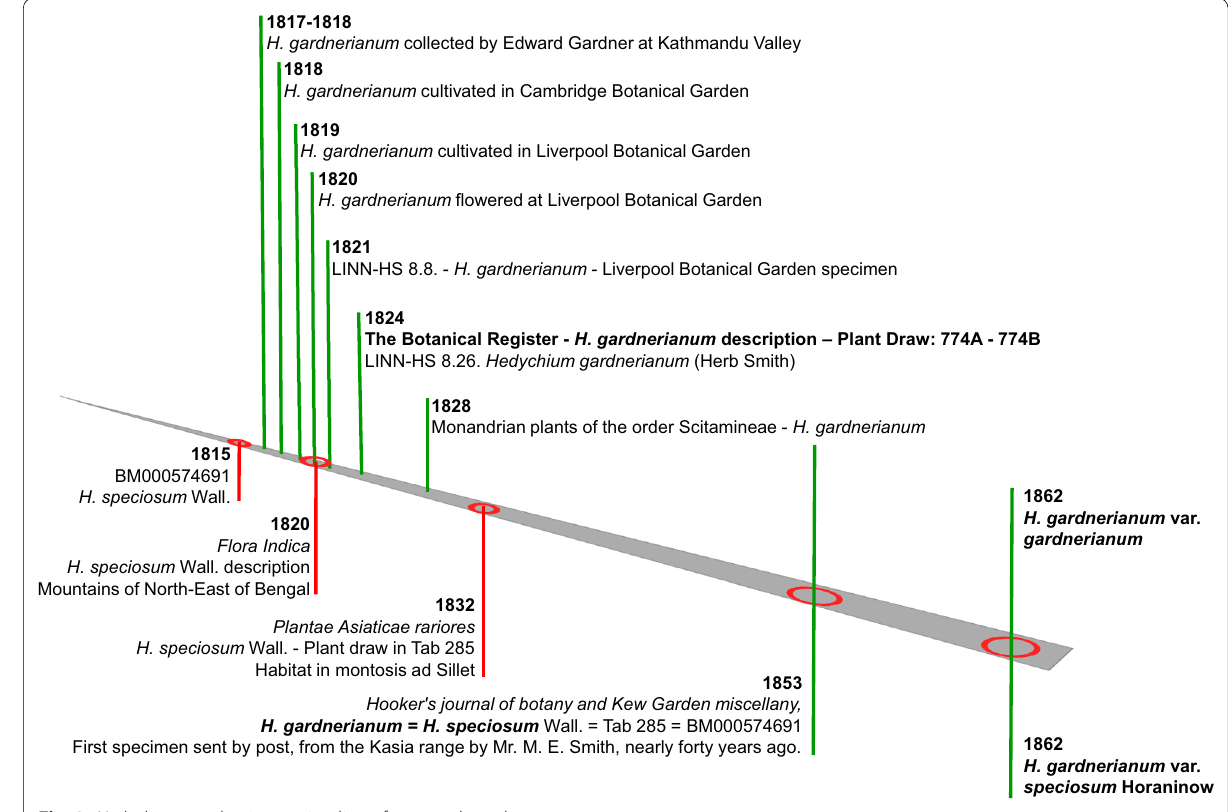
Fig. 3 Hedychium gardnerianum timeline of nomenclatural